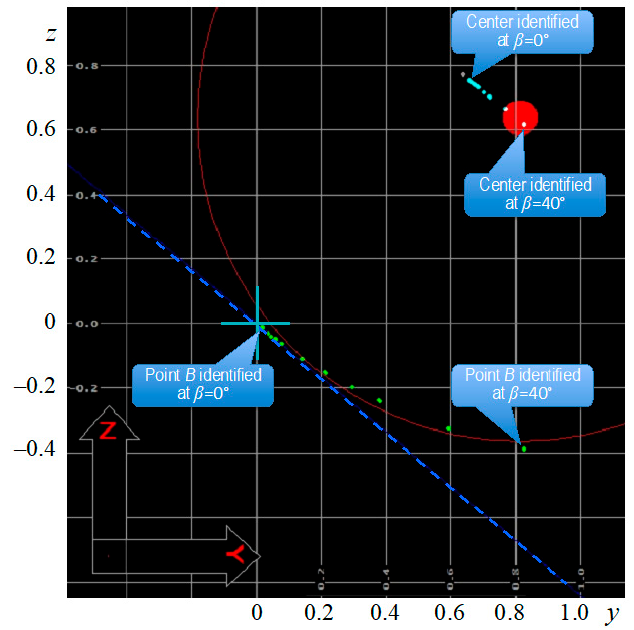
Figure 4. The screen with results after 225 measurements of the point B at α = 90° and nine different values of β , with Sample 1, Probe 1.